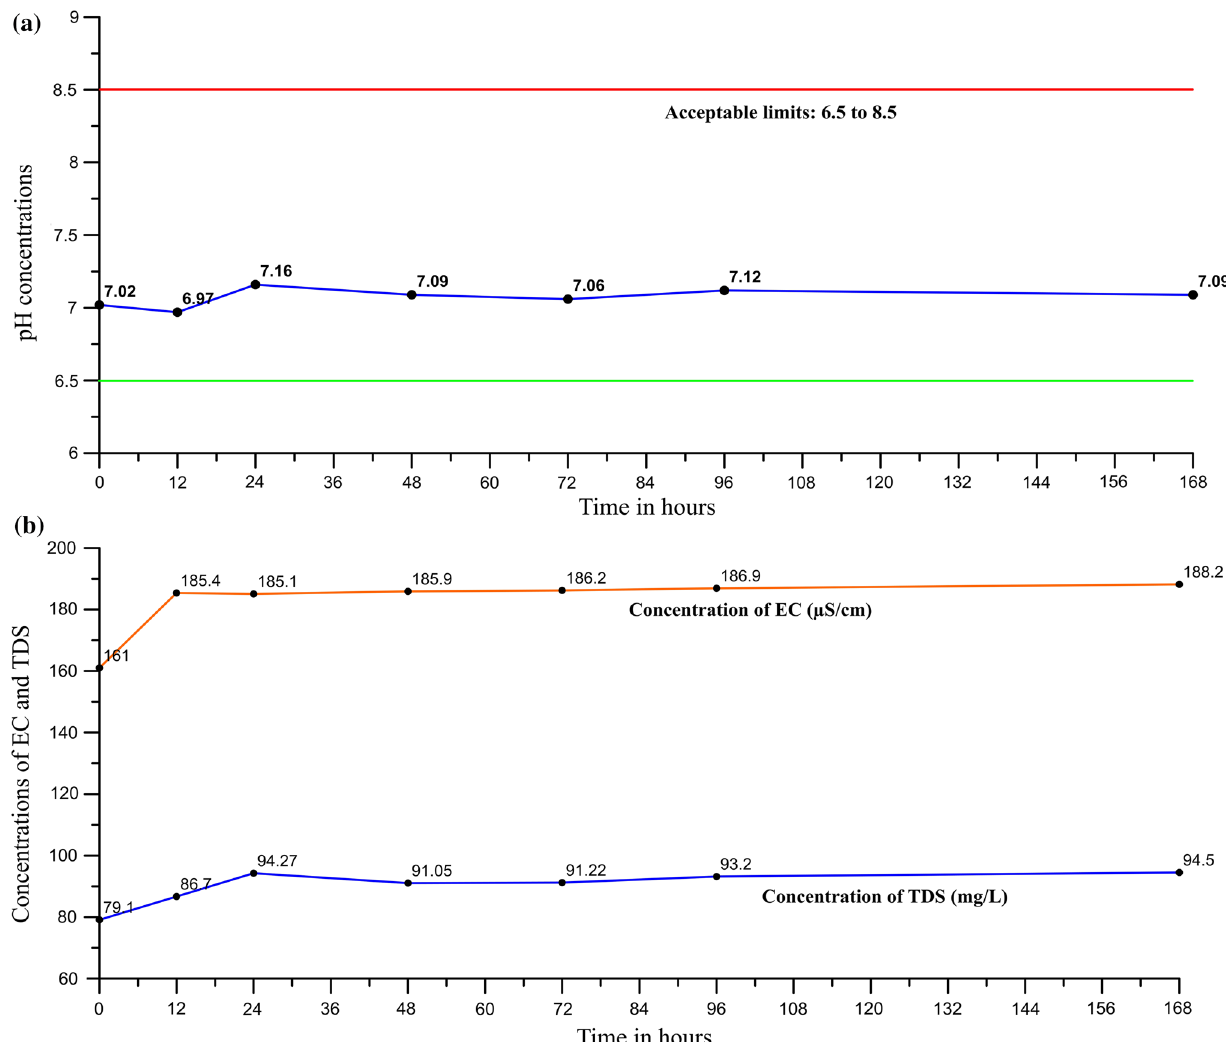
Fig. 2 Distribution of a pH versus time in hours, and b EC and TDS versus time in hours. The water samples were stored in copper containers, and measured pH, EC, and TDS in different time intervals Table 2 Summary results of calibration standards, and quality control of